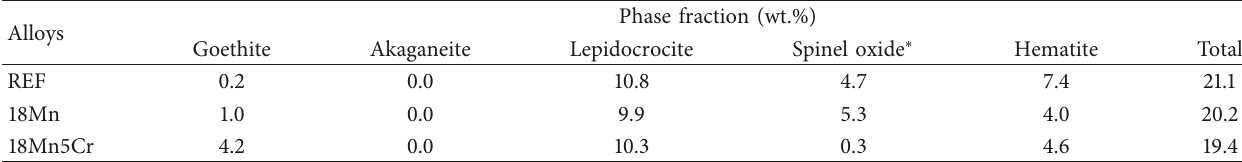
Table 5: Results on XRD qualitative analysis of nonadherent rusts (NARs) formed for 56-day exposure in 3.5% NaCl solution according to the internal standard method.